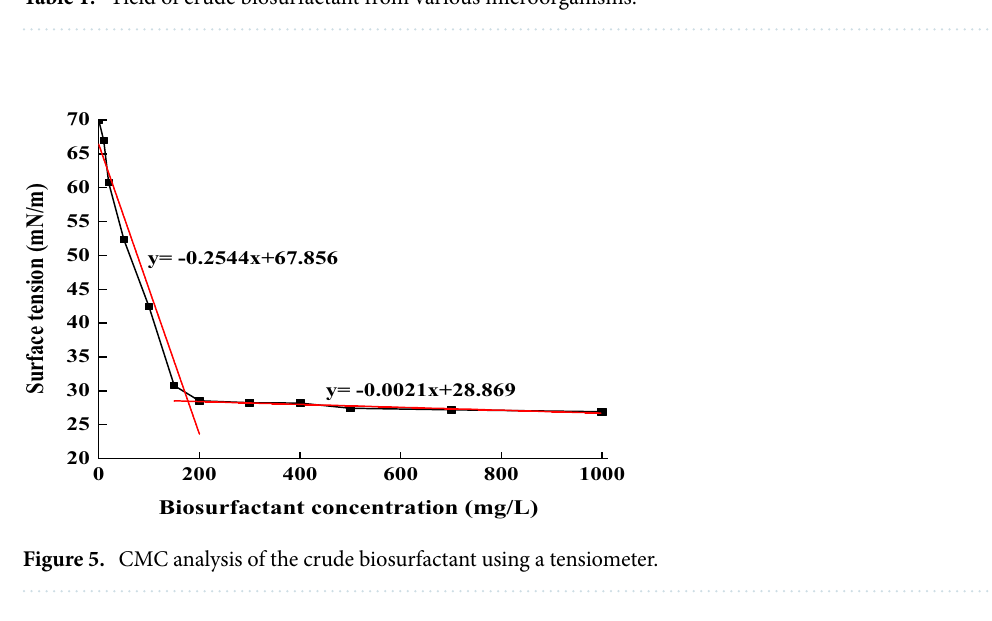
Table 1. Yield of crude biosurfactant from various microorganisms.